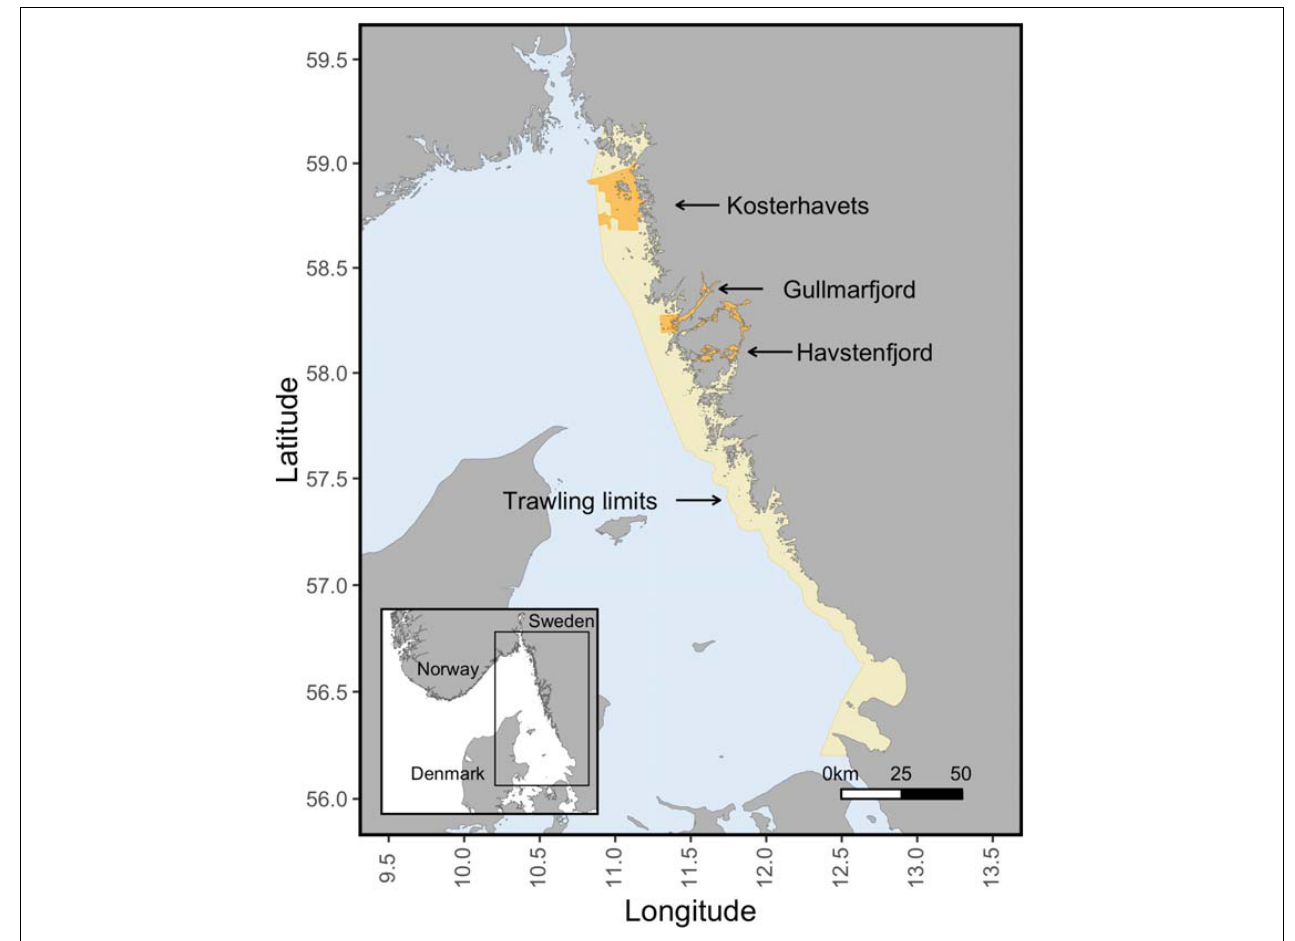
FIGURE 1 | Map of the Swedish west coast (bordering both the Baltic and the North Sea) showing the trawling limit, which define coastal and offshore waters, and the boundaries for the three MPAs: Kosterhavets, Gullmarsfjord, and